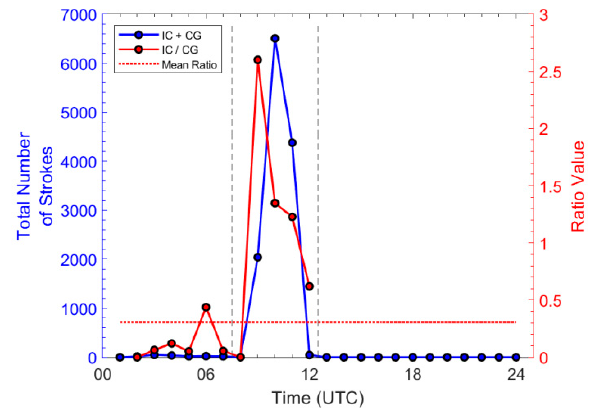
Figure 3. Hourly trend of the intra-cloud (IC) / cloud-to-ground (CG) ratio (solid red line) and total number of strokes (blue line) on 5 September 2015, over a 1 ◦ × 1 ◦ box centred on the GPS antenna. The horizontal red dashed line represents the mean value of the IC / CG ratio over the same 1 ◦ × 1 ◦ box for seven years from 2012 to 2018.